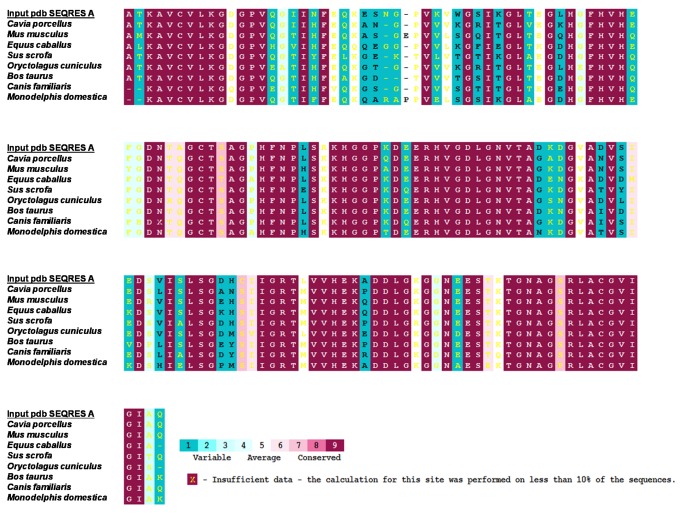
Multiple Sequence Alignment Color-Coded by Conservation.The ConSurf algorithm was used to provide conservation score for the amino acids of superoxide dismutase 1, starting from the multiple alignment of sequences of SOD1 from 8 different mammalian species that had between 80 and 100% homology with the human SOD1. The color-coding bar shows the coloring scheme: conserved amino acids are colored bordeaux, residues of average conservation are white, and variable amino acids are turquoise. Two columns are basically formed by gaps: at the position of amino acid 26, the gaps are because of sequences of human SOD1, Equus caballus and Morrodelphis domestica; while at amino acid position 28, the gaps are because of the species Mus musculus and Morrodelphis domestica. In addition, it is verified that 61.43% of the amino acids are highly conserved between the analyzed species. The asterisks on the superior region of the alignment delimit the amino acids that have mutations described in the literature.